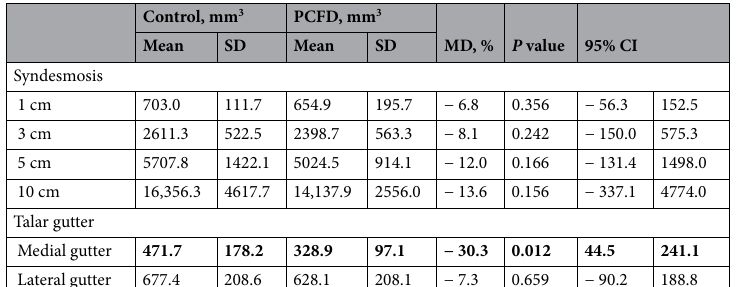
Table 2. Means and Standard Deviations for Syndesmotic Volumes Measured in Millimeters Cubed, and Mean Difference in Volume from Control to Progressive Collapsing Foot Deformity Patients with P Values and 95% Confidence Intervals for Comparisons. PCFD progressive collapsing foot deformity, MD mean difference, SD standard deviation, cm centimeter, mm millimeter, CI confidence interval. Bolded rows denote significant changes within the region. *Statistically significant ( p < .05).